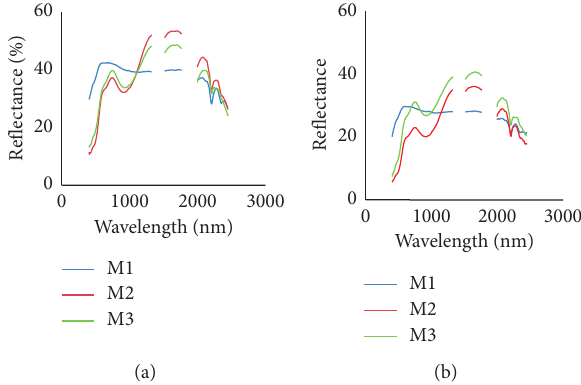
Figure 3: The average spectra of the rocks that were (a) measured in laboratory and (b) in the field.